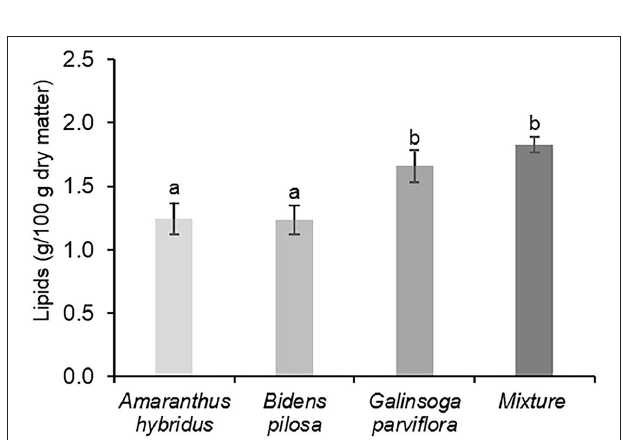
FIGURE 4 | Lipid contents of lombi . Error bars represent ± standard deviation ( n = 9). Different letters indicate significant differences between samples.